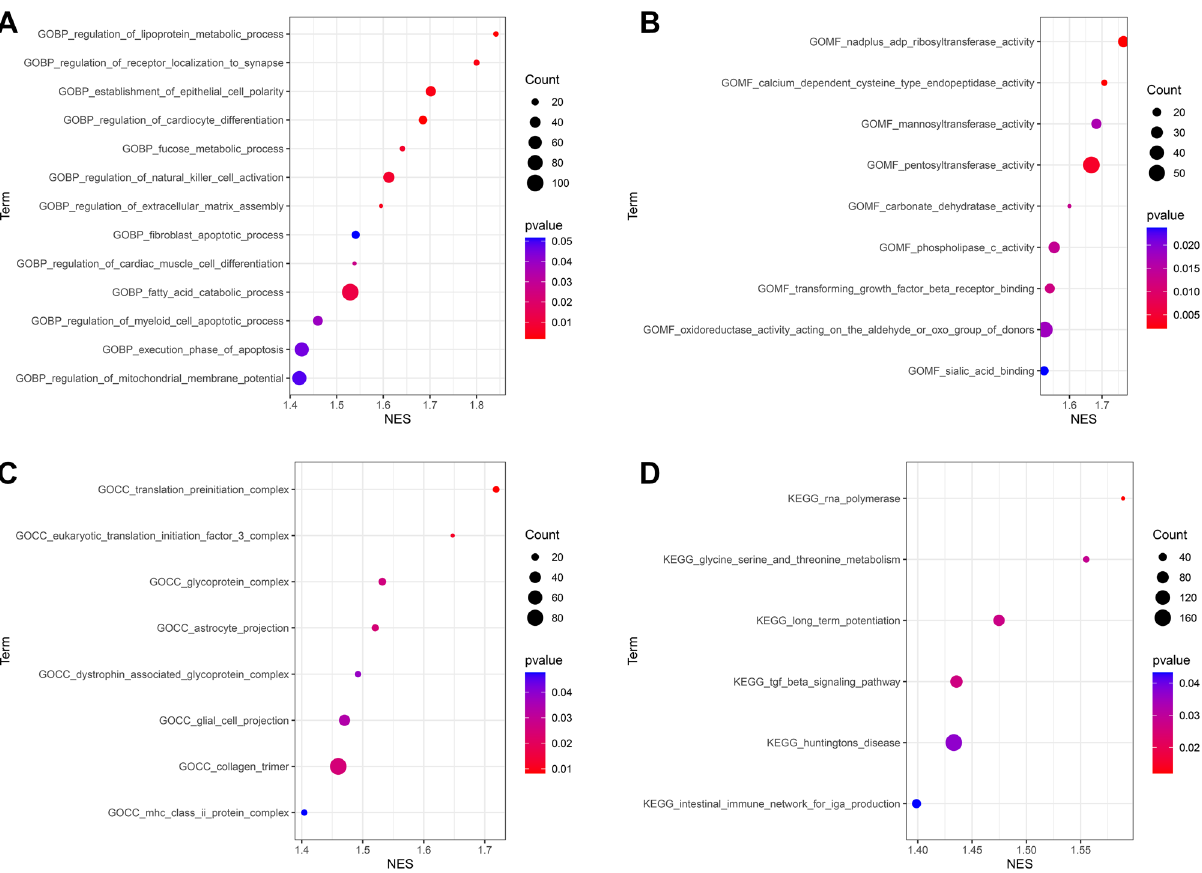
Figure 9. Function enrichment analysis of PCSK9 in AAA neck. ( A ) GO (biological process) analysis of PCSK9 in AAA neck. ( B ) GO (molecular function) analysis of PCSK9 in AAA neck. ( C ) GO (cell component) analysis of PCSK9 in AAA neck. ( D ) KEGG analysis of PCSK9 in AAA neck. NES normalized enrichment